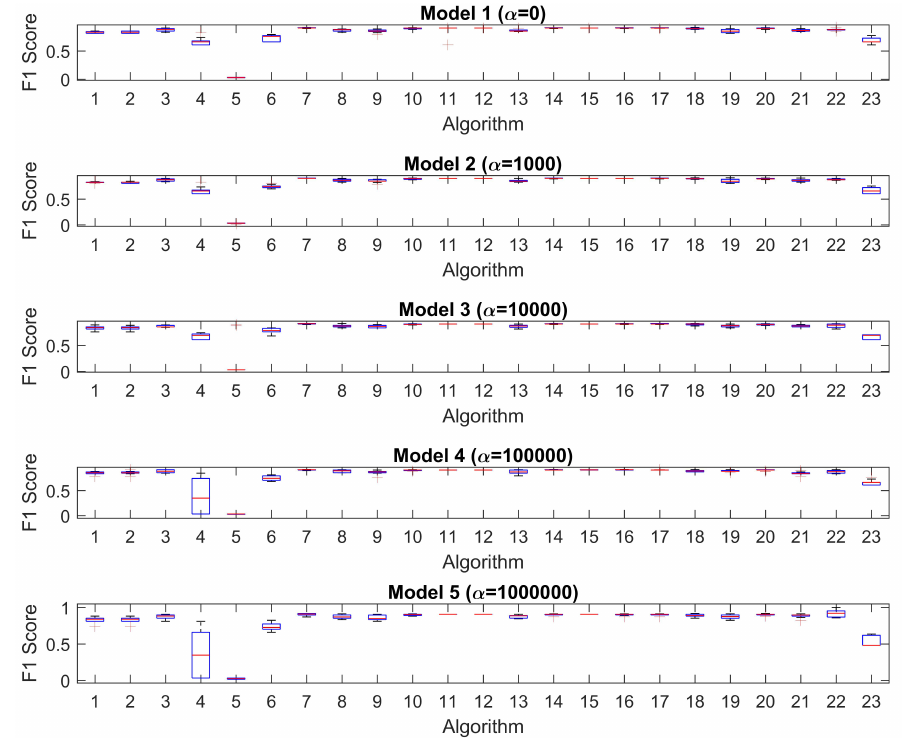
Figure A9. Numerical simulation Assumption 3 (constant). F1-score of various models after permu- tations in the numerical values of the mapping. The 23 algorithms are represented in the x -axis, and the accuracy is shown in the y -axis.